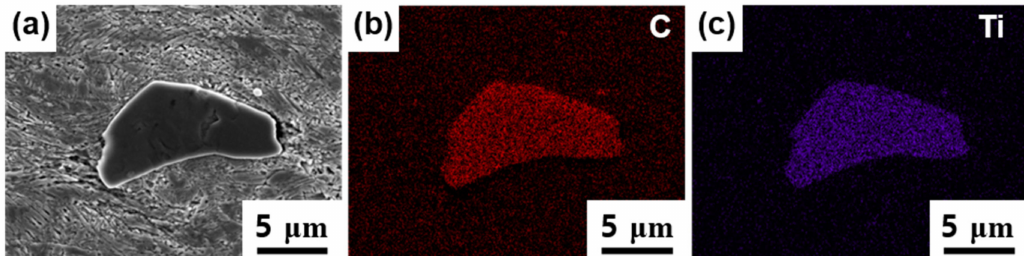
Figure 4. Energy dispersive spectrometry (EDS) chemical composition maps near a precipitate in as-rolled Fe-SMA sample. ( a ) SEM image of mapped area, ( b ) map of Carbon (C), and ( c ) Titanium